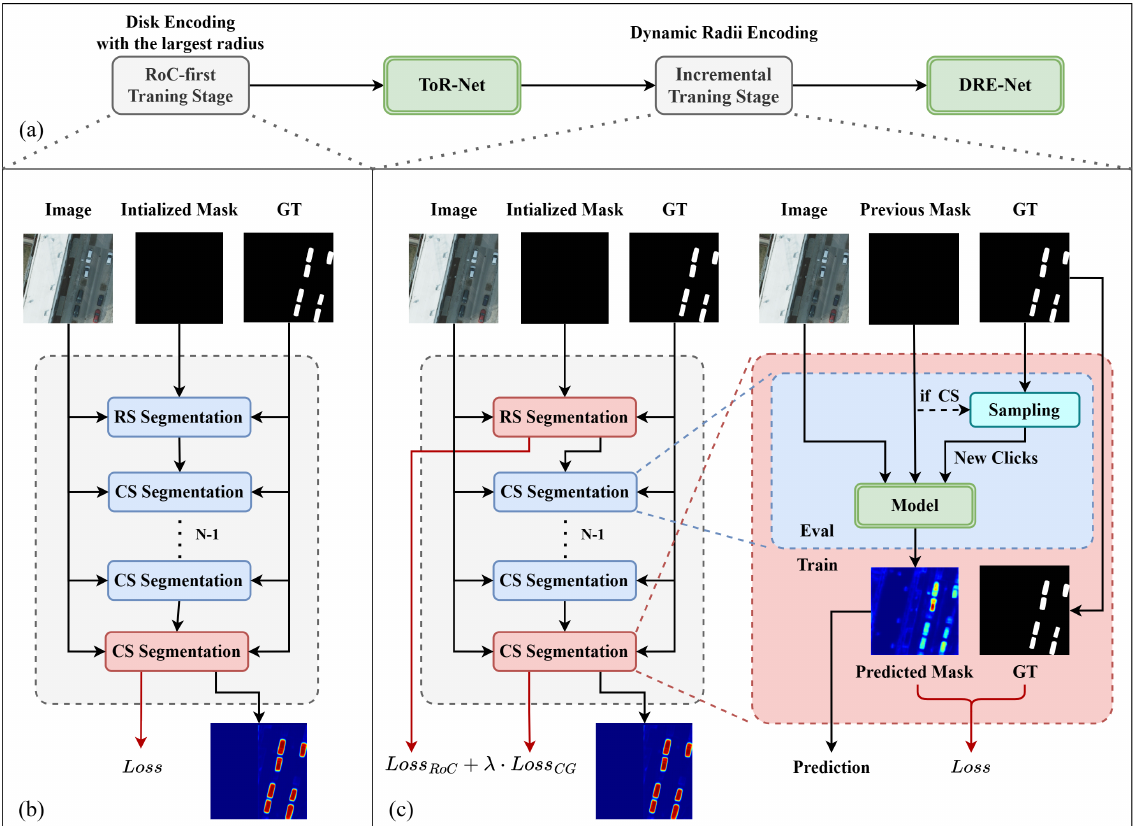
Figure 9. ( a ) Procedure of the incremental training strategy. It includes ( b ) the RoC-first training stage and ( c ) the incremental training stage. Both stages use the segmentor described in Section 3.1.4 with different click-encoding methods. We call the result of the RoC-first training stage ToR-Net (the model trained on the largest radius). The training strategy of the RoC-first training stage is consistent with those in recent works [22,24]. “RS” and “CS” in ( b , c ) stand for “random sampling” and “corrective sampling”,